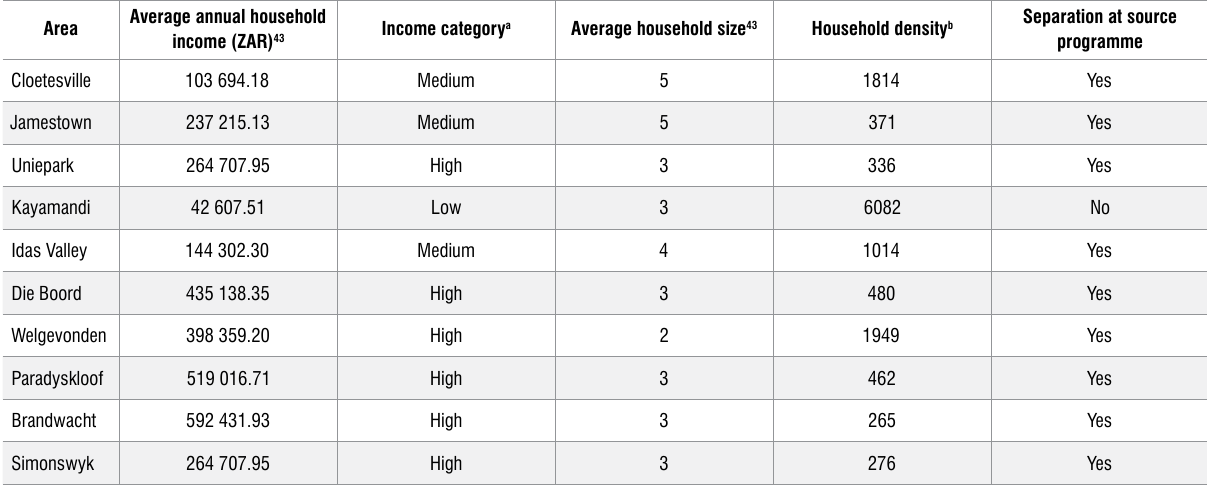
Table 4: Economic parameters for each area